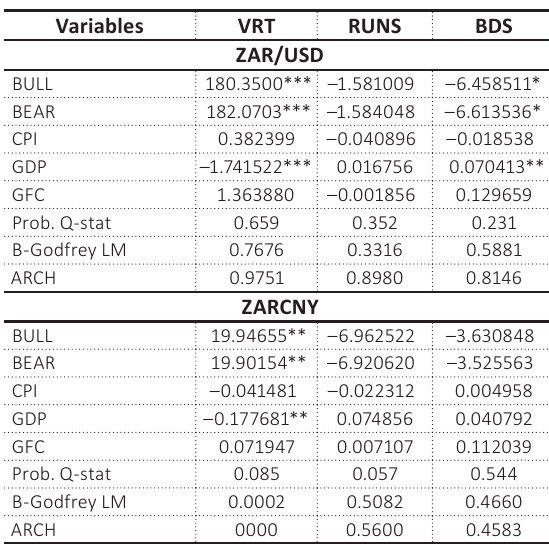
Table 1. Regression results